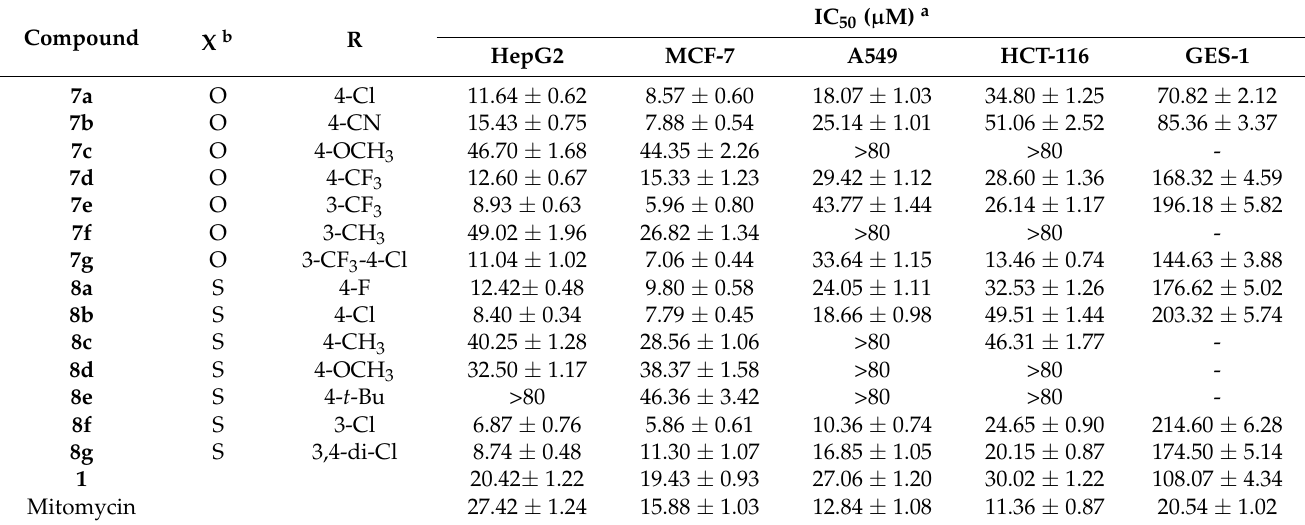
Table 1. Cytotoxicities of compounds in human cancer and normal